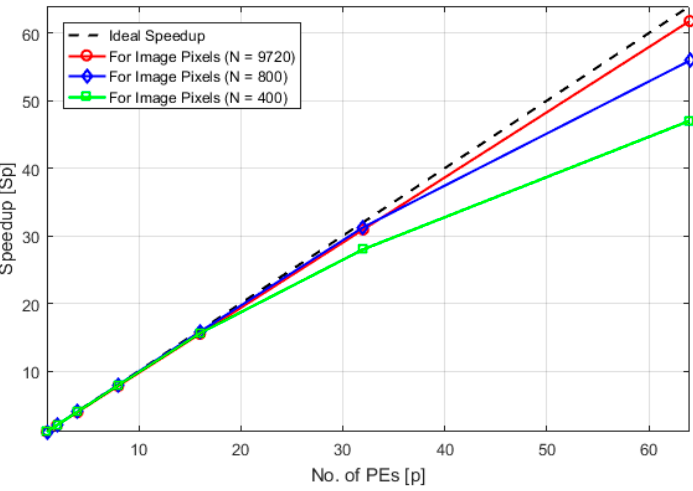
Figure 6. Comparison of speedup for different dataset sizes.